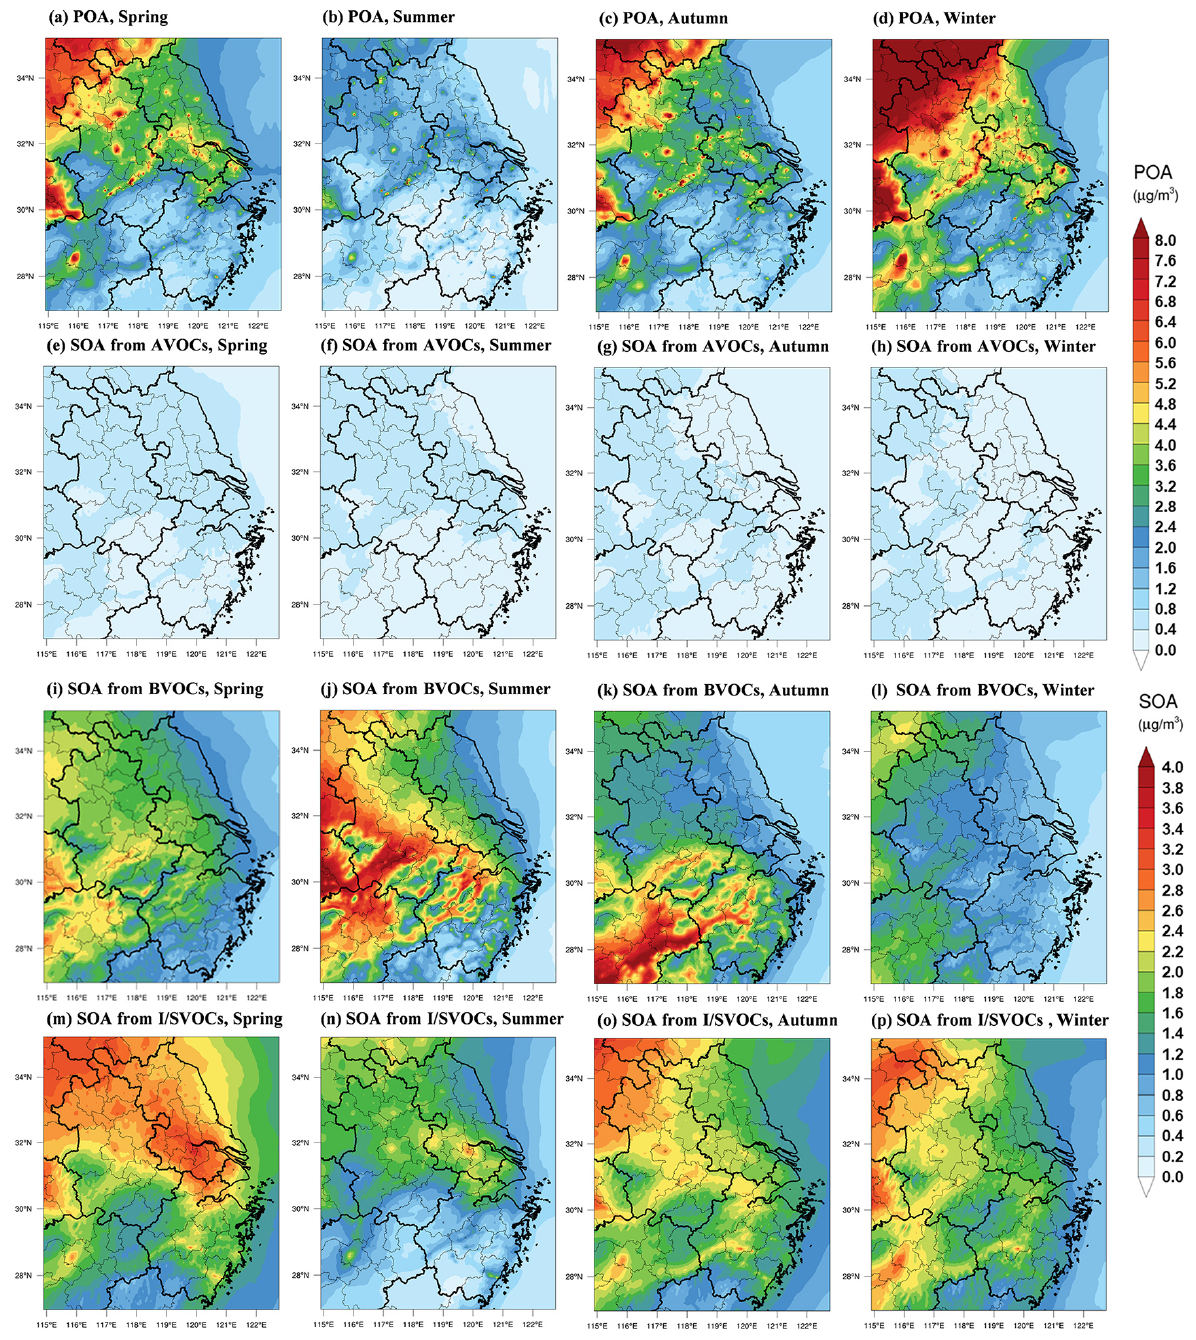
Figure 6. Spatial distributions of modeled POA and SOA formed from AVOCs, BVOCs, and I/SVOCs in different seasons in the I/SVOC-E